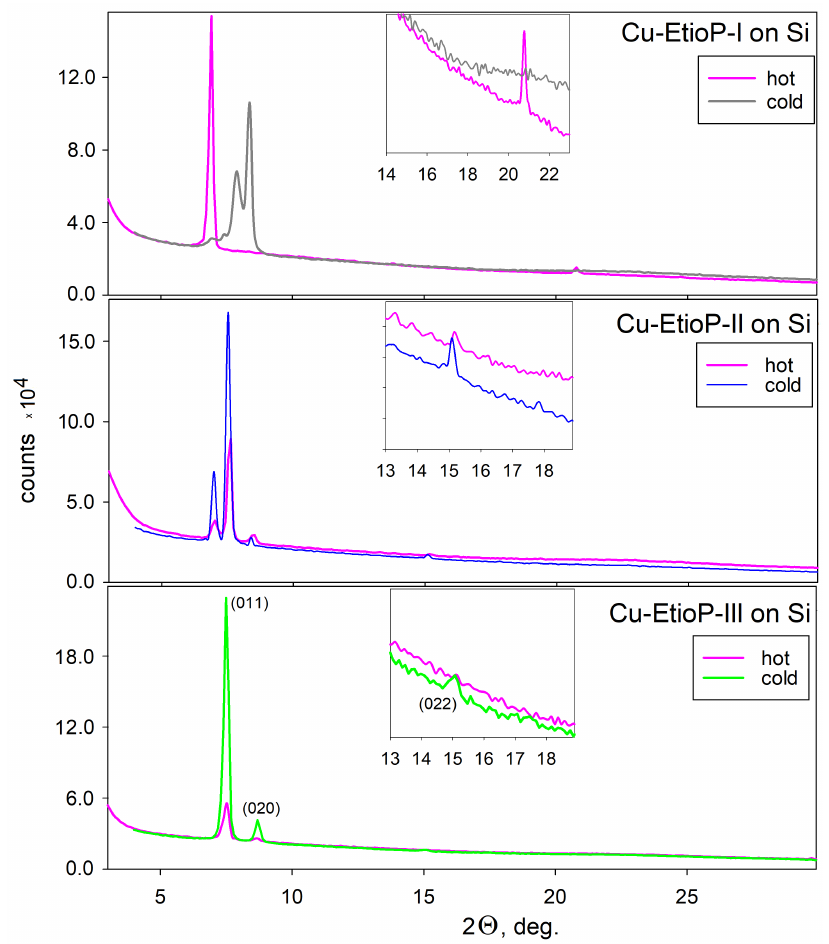
Figure 3. XRD patterns of Cu-EtioPs films deposited on cold (from [1]) and hot silicon substrates; assignment of peaks for Cu-EtioP-III is discussed in Appendix